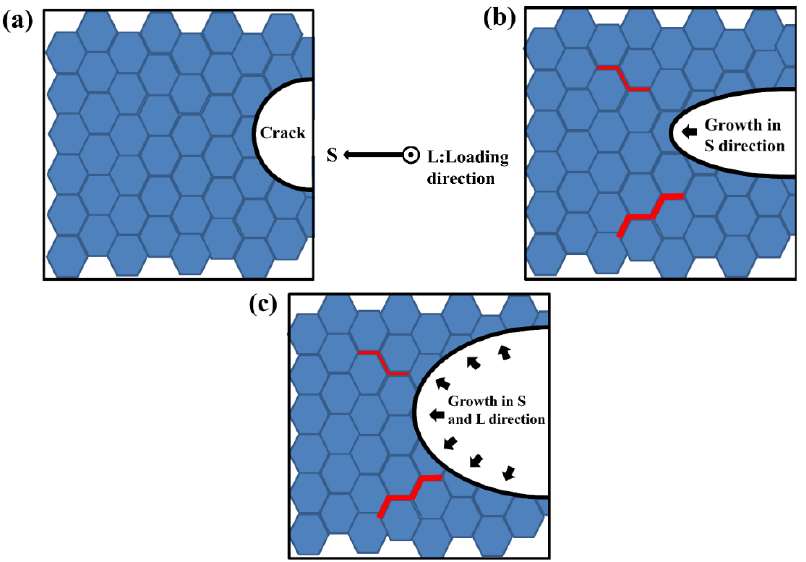
Figure 11. Model 3 of secondary crack evolution in the longitudinal plane during main crack propagation. The red bold line segment is assumed to be secondary microcracks. ( a ) Crack initiation stage; ( b ) Early crack propagation; ( c ) Stage of rapid crack propagation.